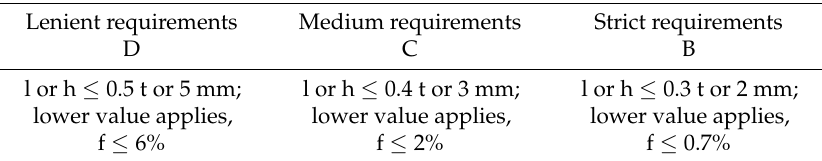
Table 3. Ultimate limit sizes of welding imperfections in the form of gas pores in accordance with PN-EN ISO 13919-1:2002 standard [33].